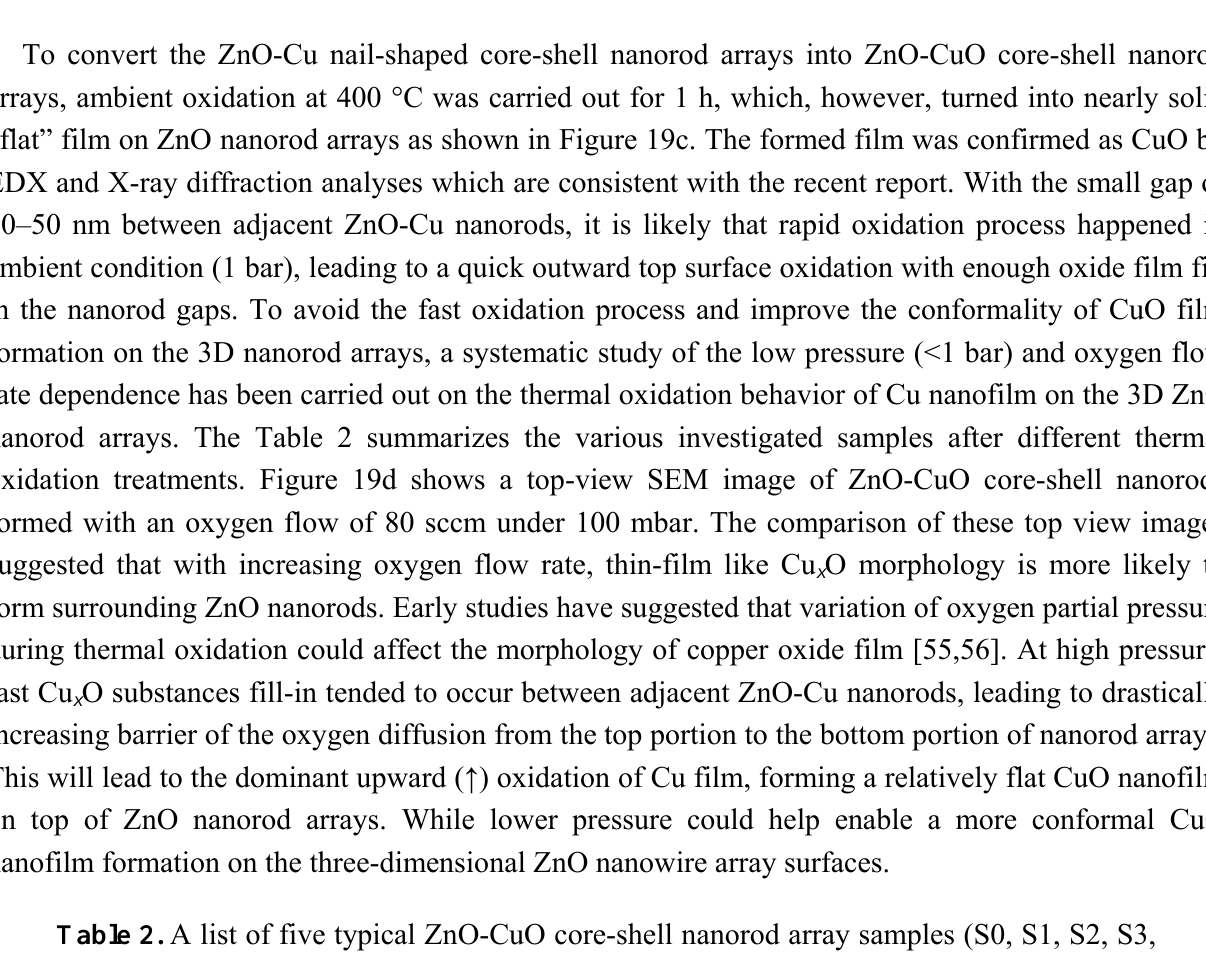
Table 2. A list of five typical ZnO-CuO core-shell nanorod array samples (S0, S1, S2, S3, and S4) formed after various thermal oxidation processes with different pressure and oxygen flow rate